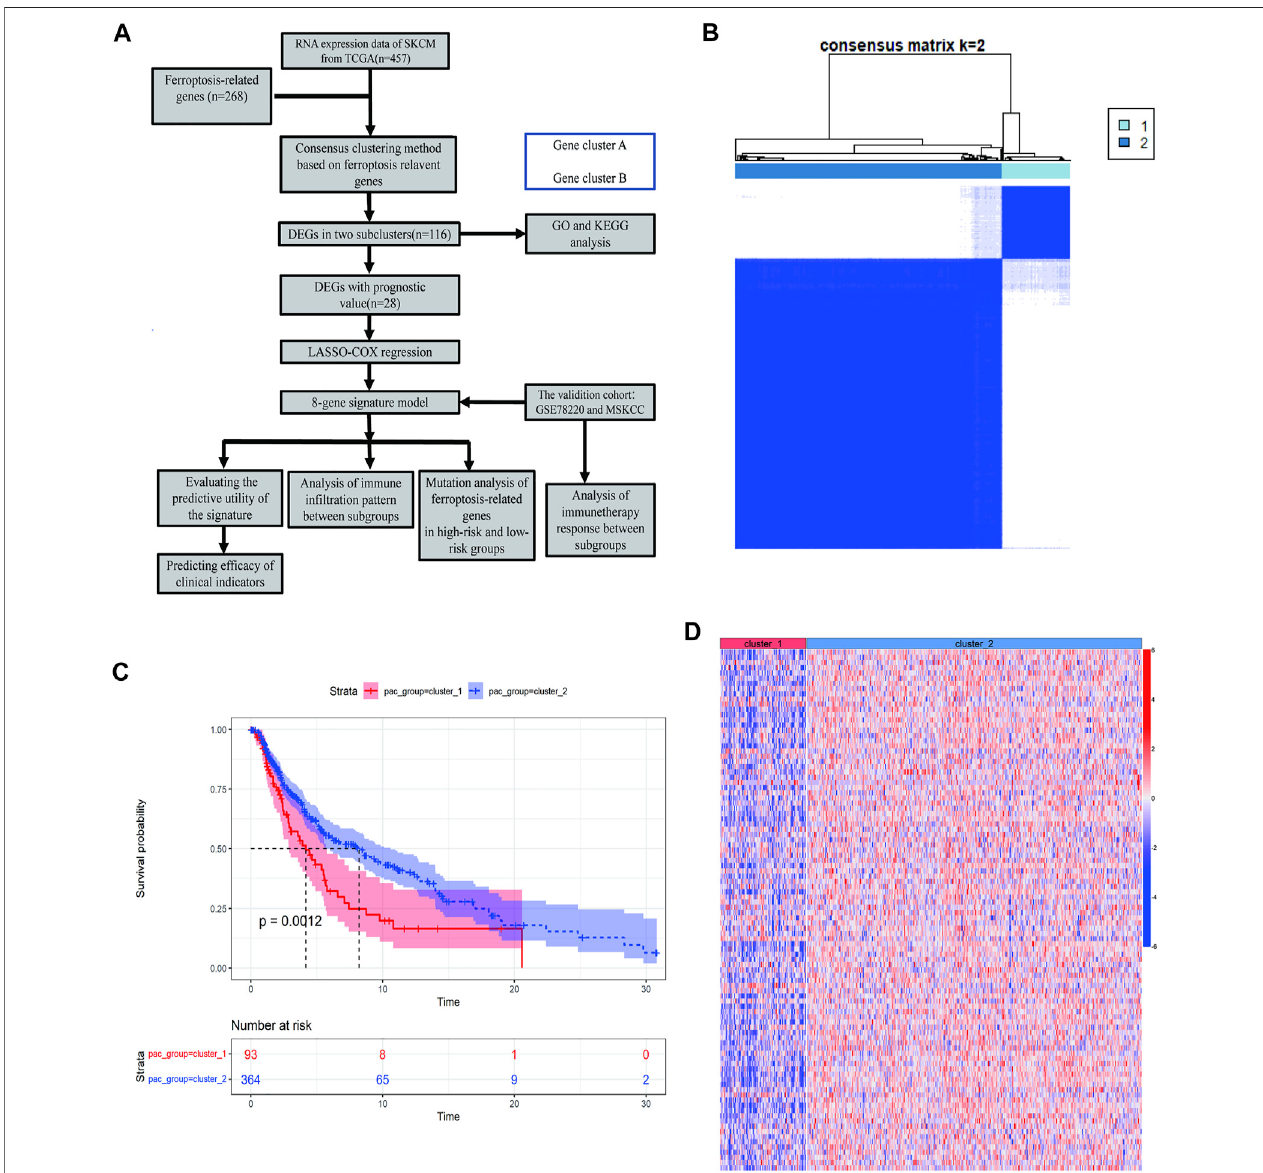
FIGURE1| Identi fi cation ofmelanoma subtypesusingconsensusclusteringintheferroptosisset. (A) Flowchartofthestudy. (B) Consensusclusteringapplied on 268 ferroptosis-related genes. Samples were divided into cluster 1 and cluster 2. (C) Survival analysis of samples in Clusters 1 and 2 in TCGA cohort. (D) Heat map of ferroptosis-related genes expression in different